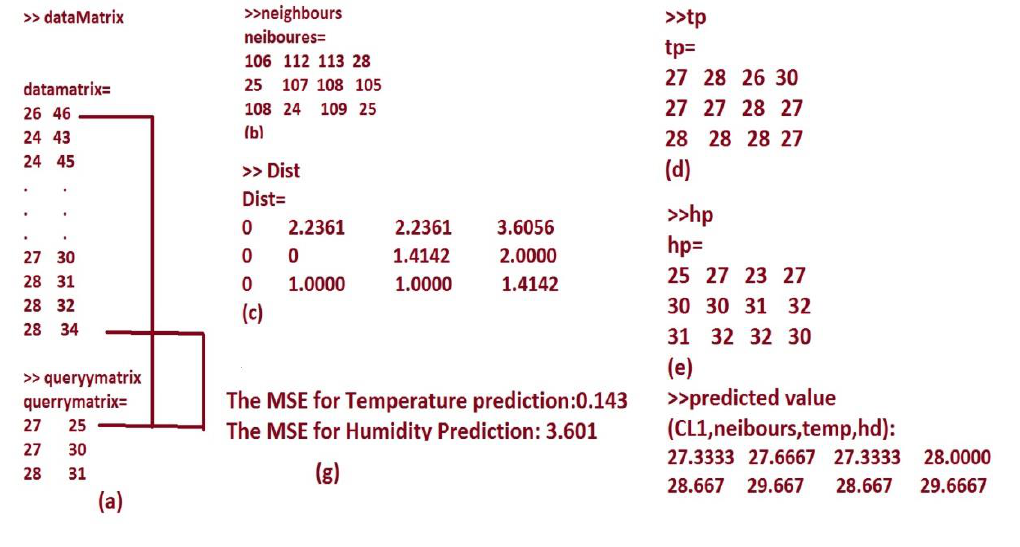
Figure 15. Overall layout of NN